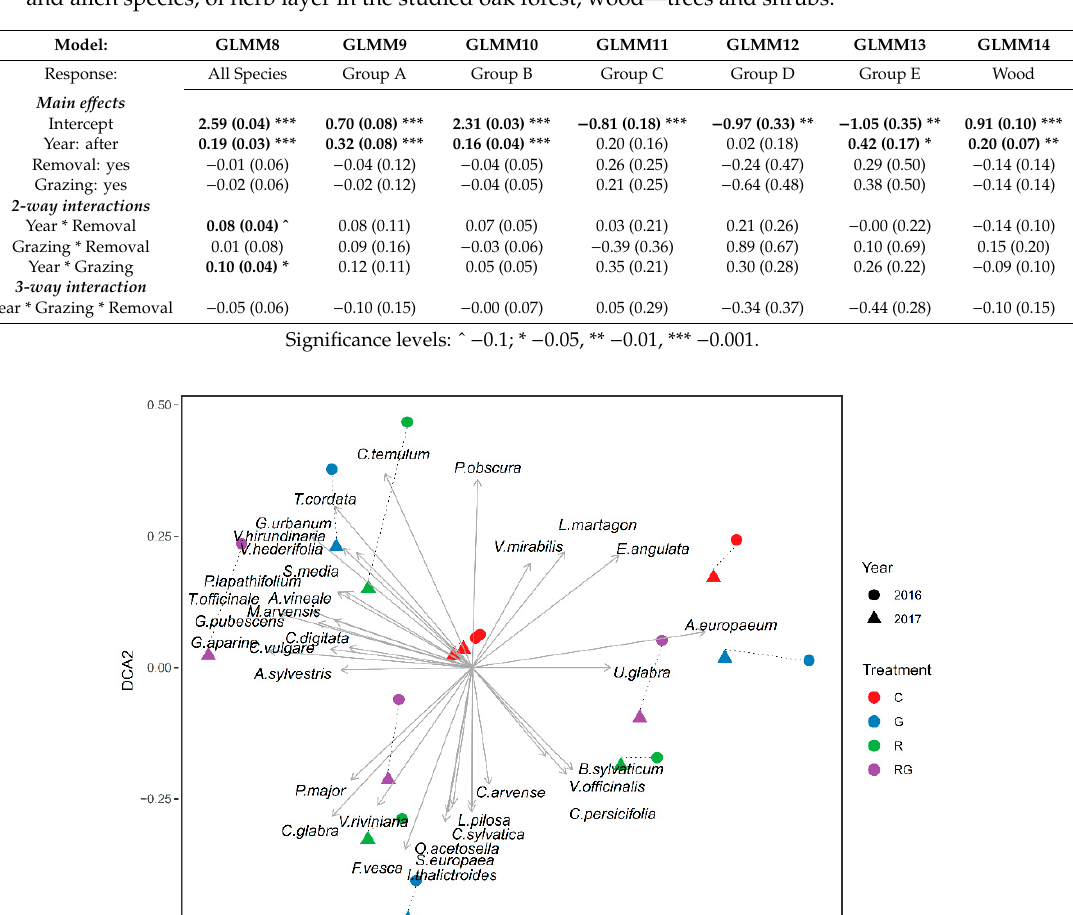
Table 2. Generalised linear mixed models with Poisson error structure analysing species richness of plants groups in relation to conservation measures (mechanical removal and grazing) and over time. For each model parameter estimates accompanied by SE in brackets are given, symbols indicating significance level are explained in Table 1, significant e ff ects are bolded. Plant ecological